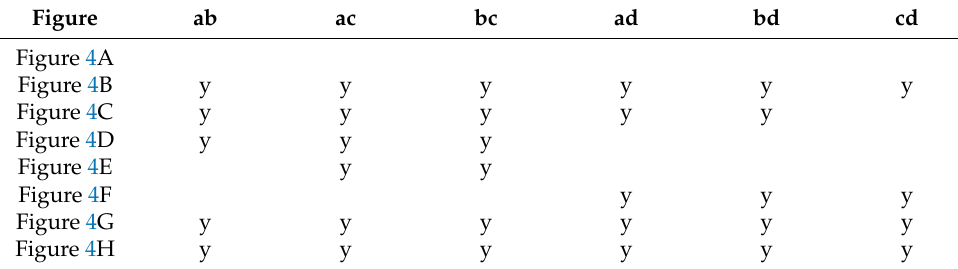
Table 3. Availability of connections among networks a, b, c and d in Figure 4.